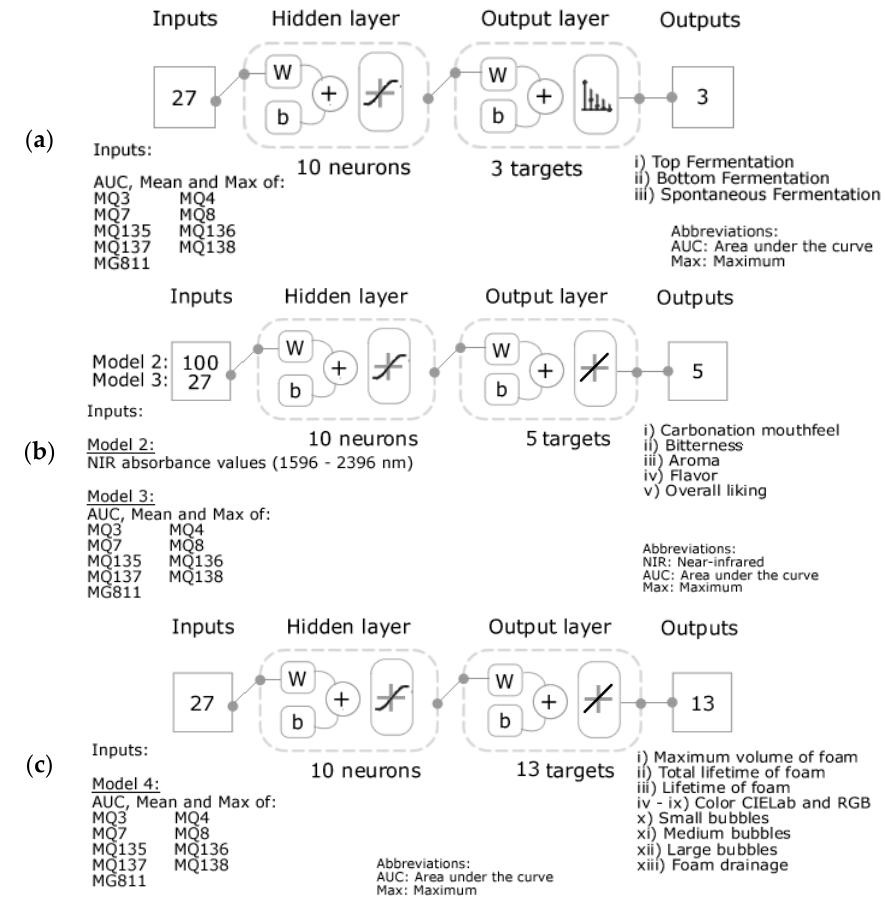
Figure 2. Diagrams of the two-layer feedforward artificial neural networks showing ( a ) pattern recognition Model 1 with a tan-sigmoid function in the hidden layer and Softmax neurons in the output layer, ( b , c ) regression Models 2–4 with a tan-sigmoid function in the hidden layer and a linear transfer function in the output layer.